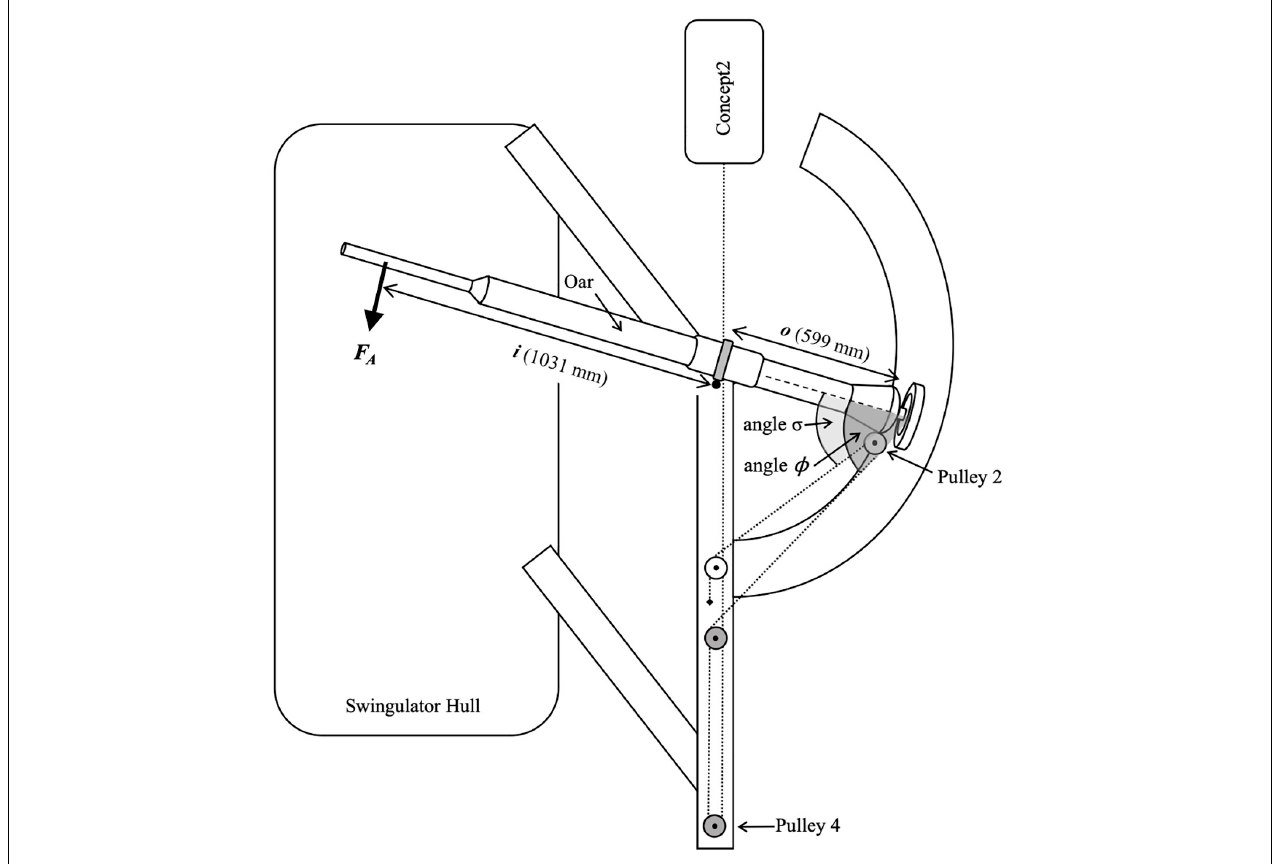
FIGURE 5 | Free body diagram of Swingulator-system illustrating the location of the applied force ( F A ), distance i , distance o , angle σ , and angle φ in Equation